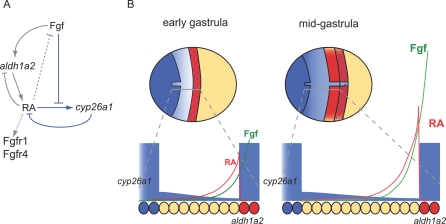
Model of Hindbrain Patterning by RA(A) Diagram of interactions between RA, Fgf, and cyp26a1. Only those shown in blue are included in the mathematical model; dotted lines are extrapolated from other animal models.(B) Schematics illustrate dorsal views of gastrulating embryos and corresponding gradients, anterior to the left. RA is produced by Aldh1a2 in somitic mesoderm (red) and diffuses through the neurectoderm. Cyp26a1 (blue) degrades RA at differing rates to produce a gradient across the hindbrain that specifies rhombomere fates. The regulation of cyp26a1 by both Fgf and RA signaling creates a robust RA gradient that grows appropriately as the A–P axis of the embryo elongates.